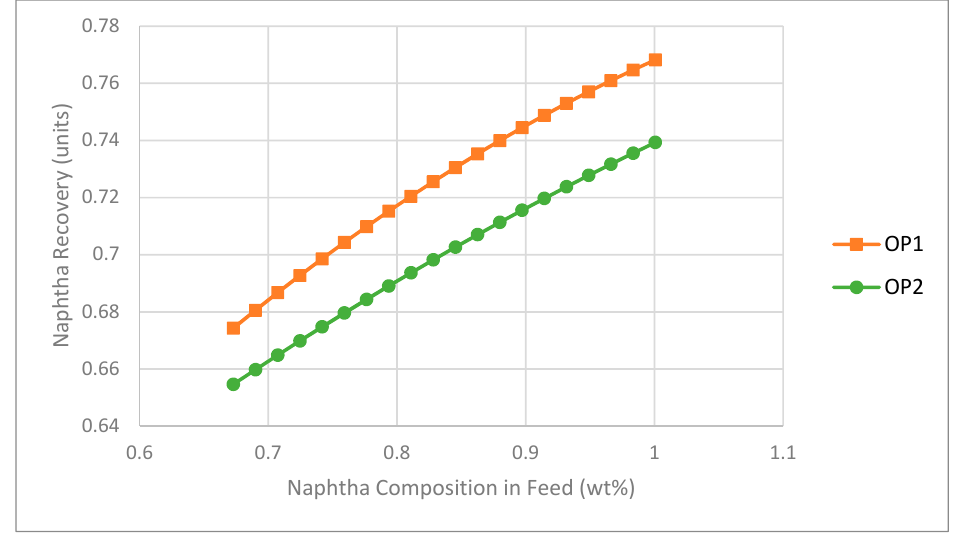
Figure 6. Impact of naphtha mass fraction in the feed on naphtha recovery (NR) as predicted by statistical models ( SF = 0.562).